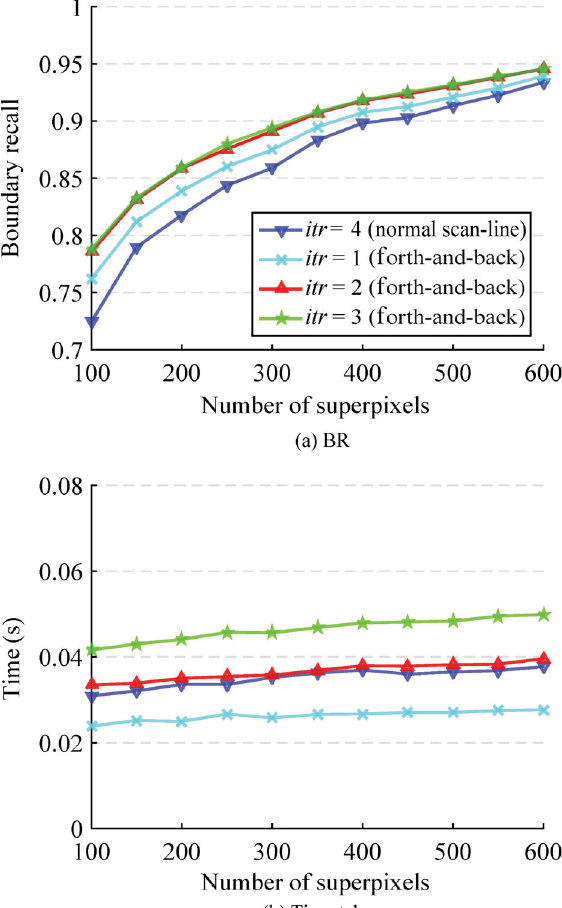
Fig. 8 Partial sensitivity analysis for standard evaluation metrics and time